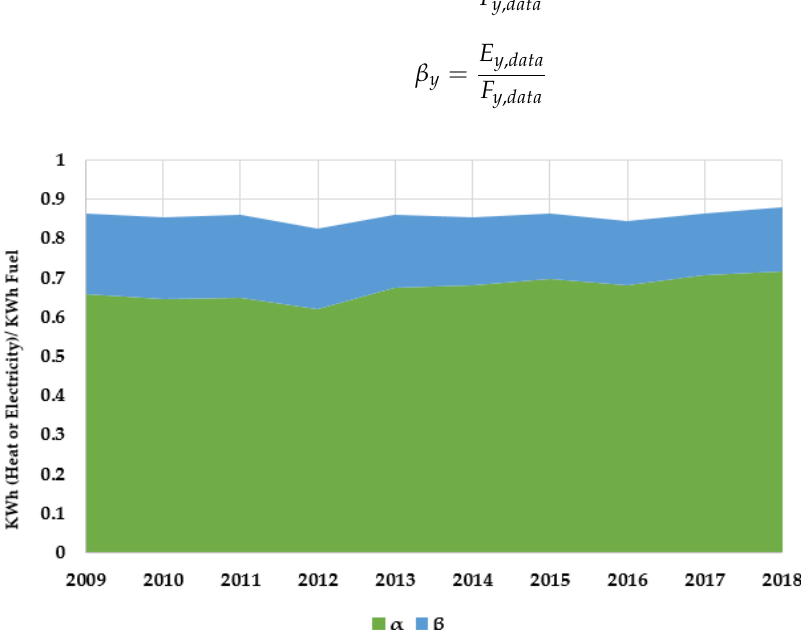
Figure 6. Evolution of α and β from 2009 to 2018 [9,29–33].